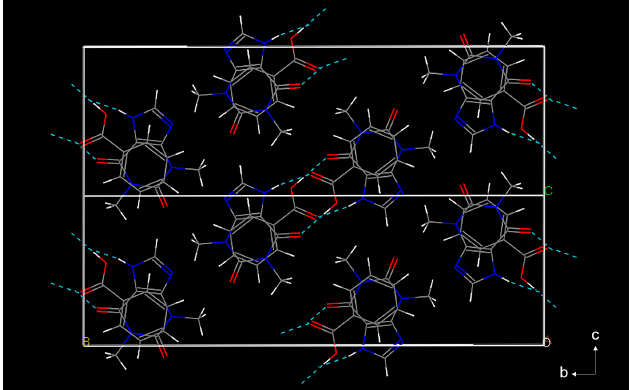
Figure 3. The crystal structure of the TP-BA cocrystal (grey color: C; red color: O; blue color: N; white color: H). Crystals 2019 , 9 , x FOR PEER REVIEW